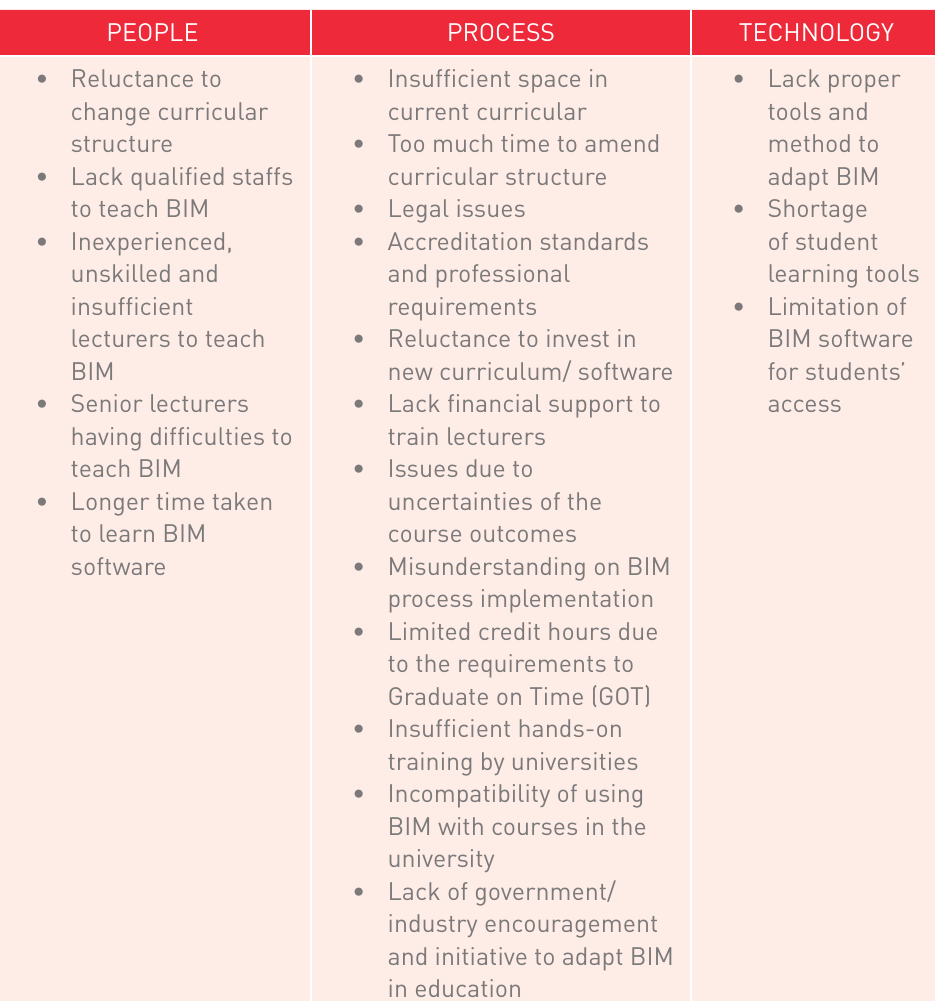
Barriers in association with people, process and technology